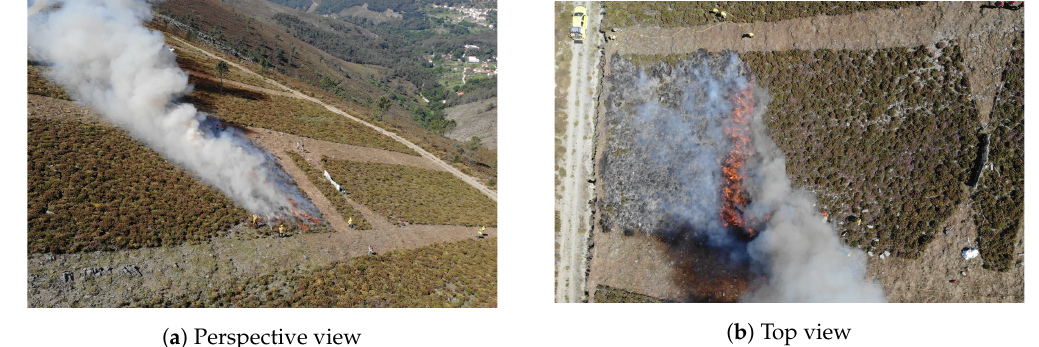
Figure 15. Experiments in mountain range field